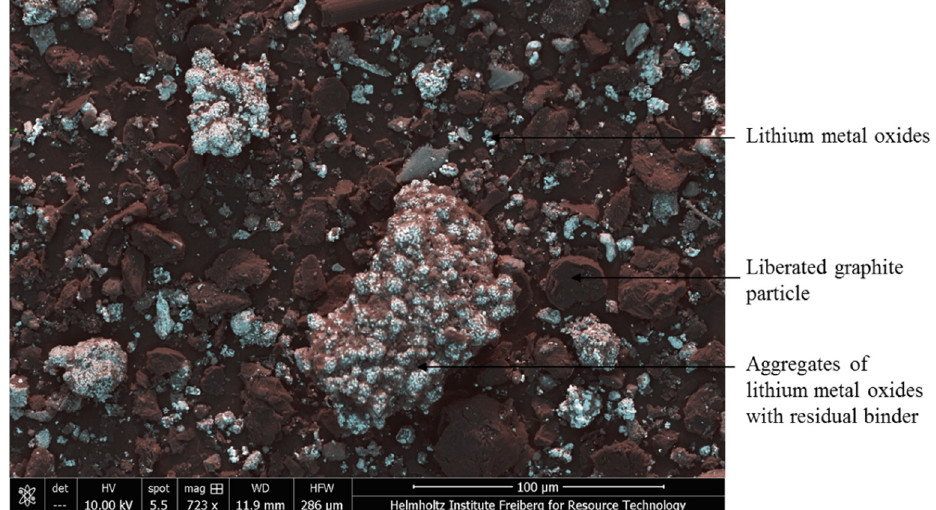
Figure 6. SEM image with imposed color of the spent black mass before attrition. The composition is represented by false color differences, blue was imposed for high atomic numbers (e.g., Co, Ni, Mn) and black for low atomic numbers (e.g., C, F).